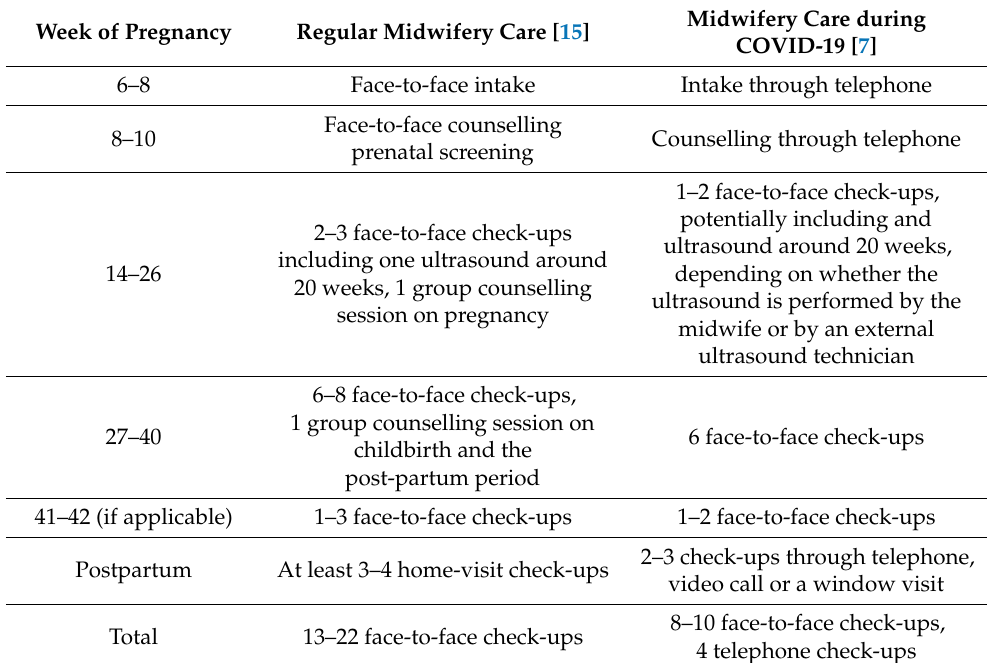
Table 1. Regular midwifery care vs COVID-19 midwifery care in the Netherlands, according to the KNOV (Royal Dutch Midwifery